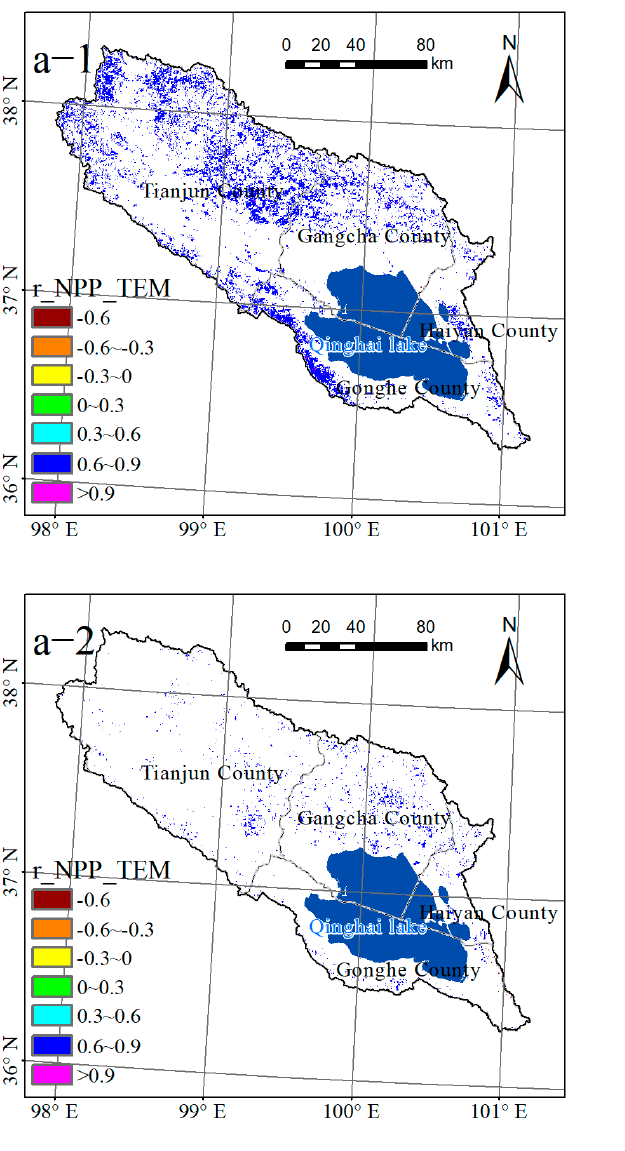
Figure 7. Partial correlation coefficients between net primary productivity (NPP) and temperature ( a-1 , a-2 ) and precipitation ( b-1 , b-2 ) in the Qinghai Lake Basin. (1 and 2, respectively, represent 2001–2010 and 2010–2020).